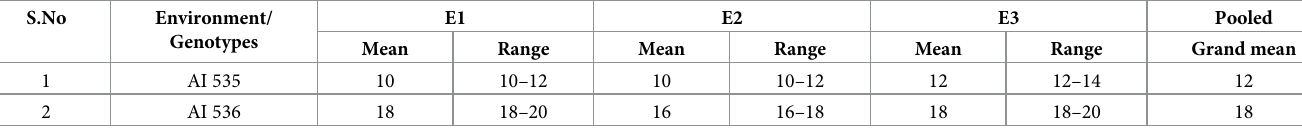
Table 2. Mean and range for KRN trait of selected genotypes across environments.